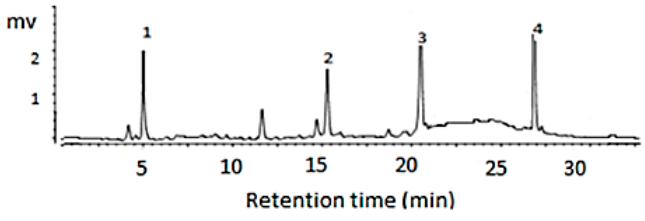
Figure 1. Chromatography of the aqueous extract of Punica granatum L. The peaks represent gallic acid [1], punicalagin α [2], punicalagin β [3], and ellagic acid [4] at 260